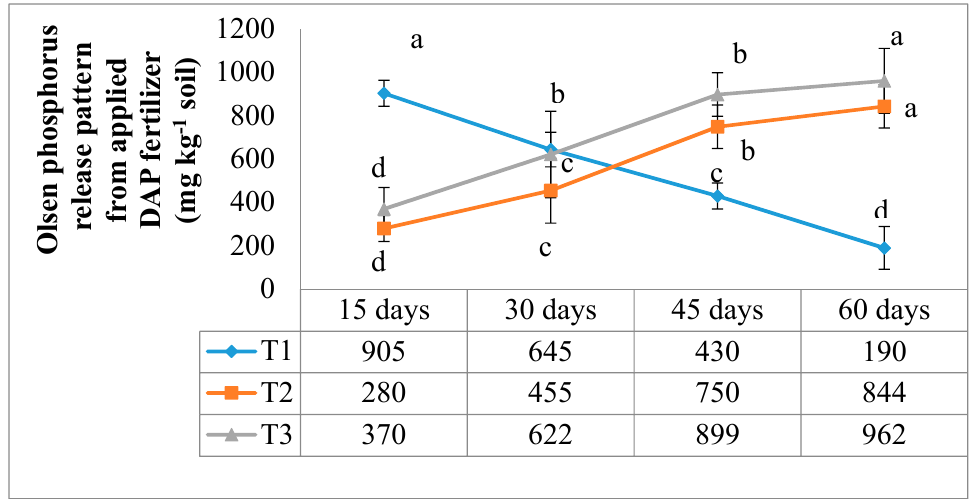
Figure 2. Phosphorus release pattern in soil treated with coated and uncoated DAP fertilizer at field capacity moisture level over di ff erent time intervals of incubation. Note: Values sharing the same letter did not di ff er significantly at 5% level of significance. DAP—diammonium phosphate;